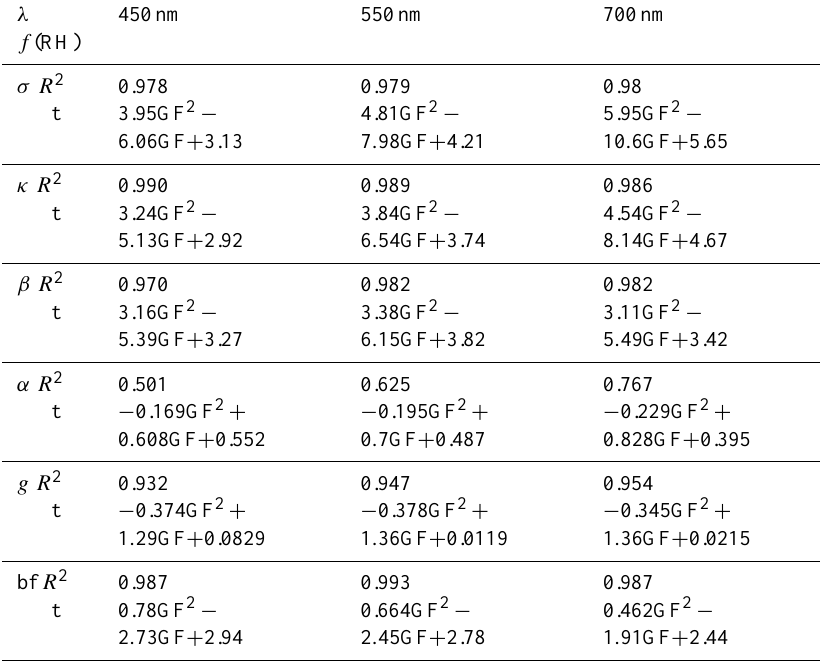
Table 3. Regression analysis between enhancement factors f (RH) and growth factor